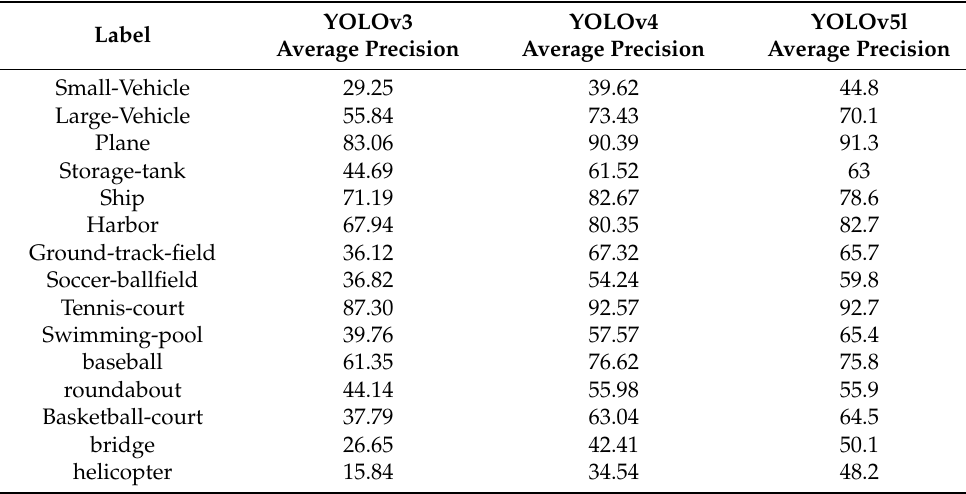
Table A1. Performance of YOLOv3, YOLOv4, and